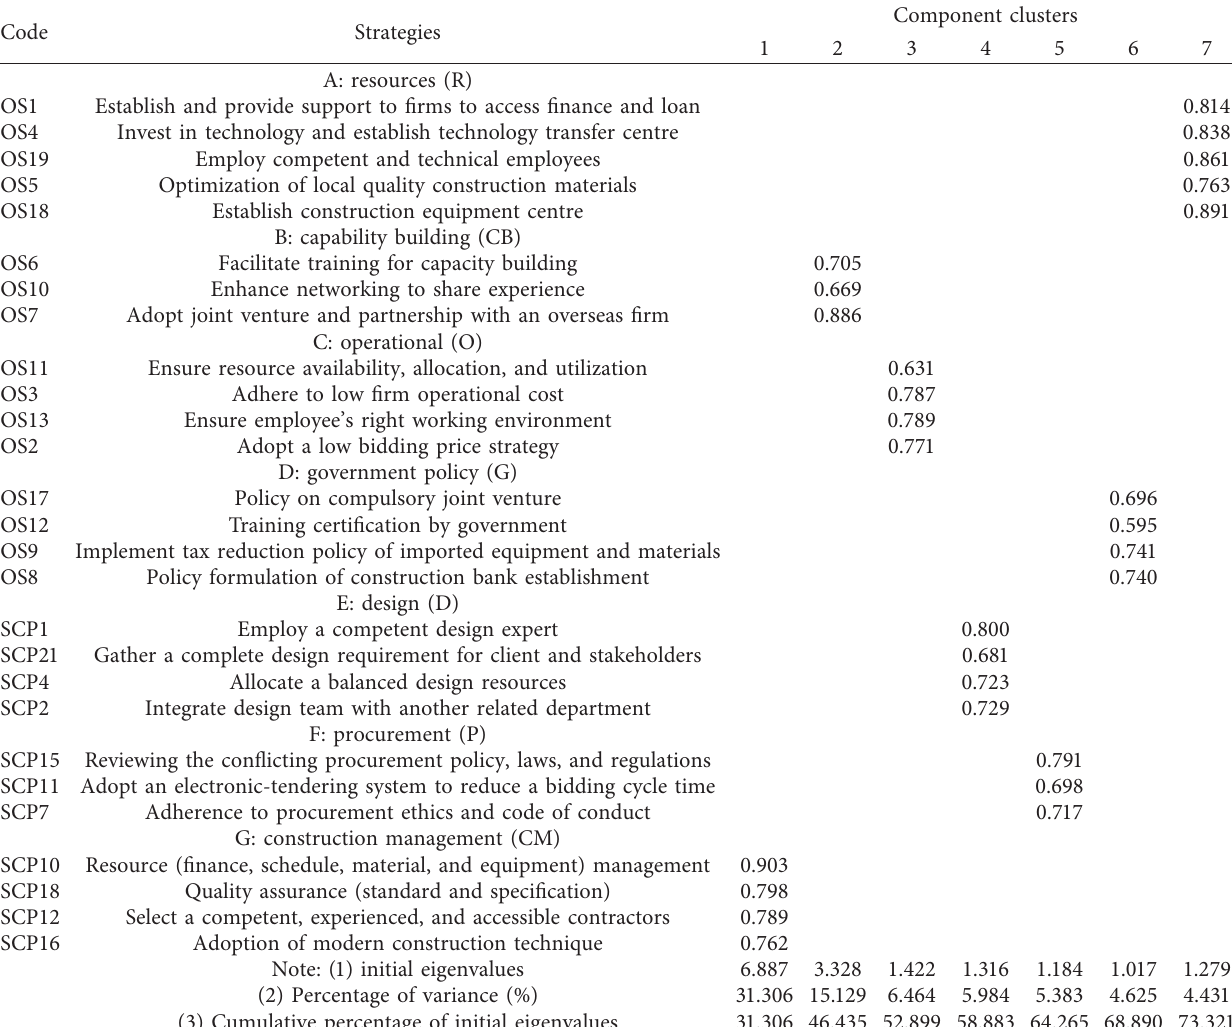
Table 9: Rotated component matrix of prioritized